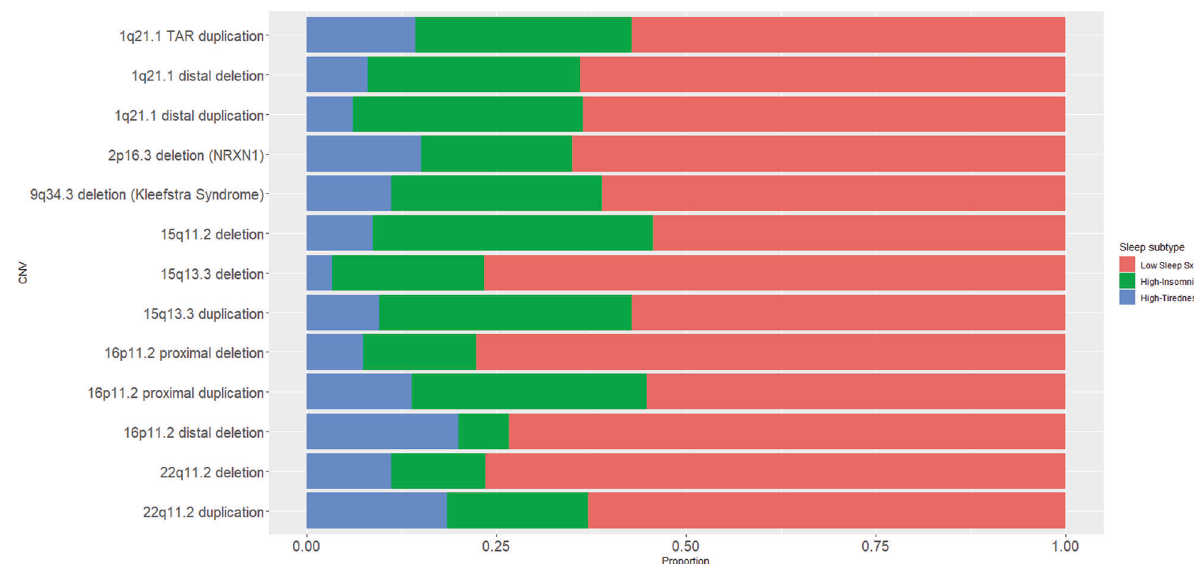
Fig. 1 Sleep class pro fi le for each ND-GC genotype. For each ND-GC genotype, the proportion of individuals who have each sleep subtype (Low Sleep Sx, High-Insomnia and High-Tiredness), as derived by latent class analysis.